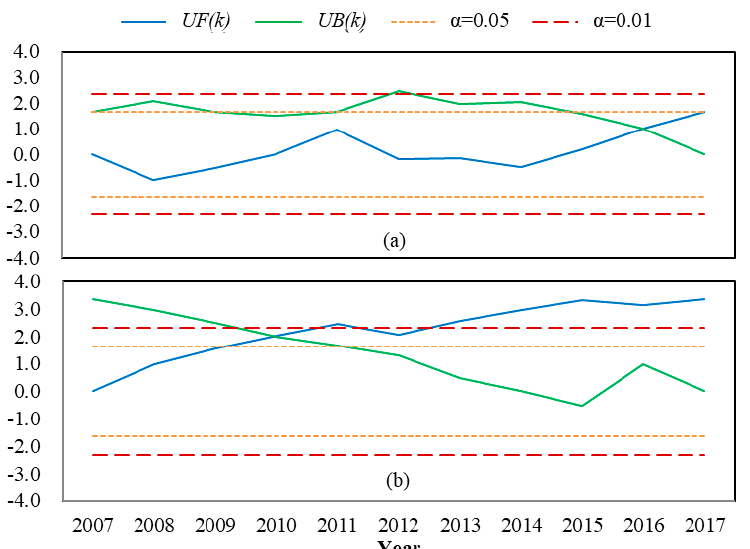
Figure 8. Unconfined and confined water depth TFPW-Mann–Kendall test results. Unconfined depth TFPW-Mann–Kendall test ( a ), Confined depth TFPW-Mann–Kendall test ( b ).